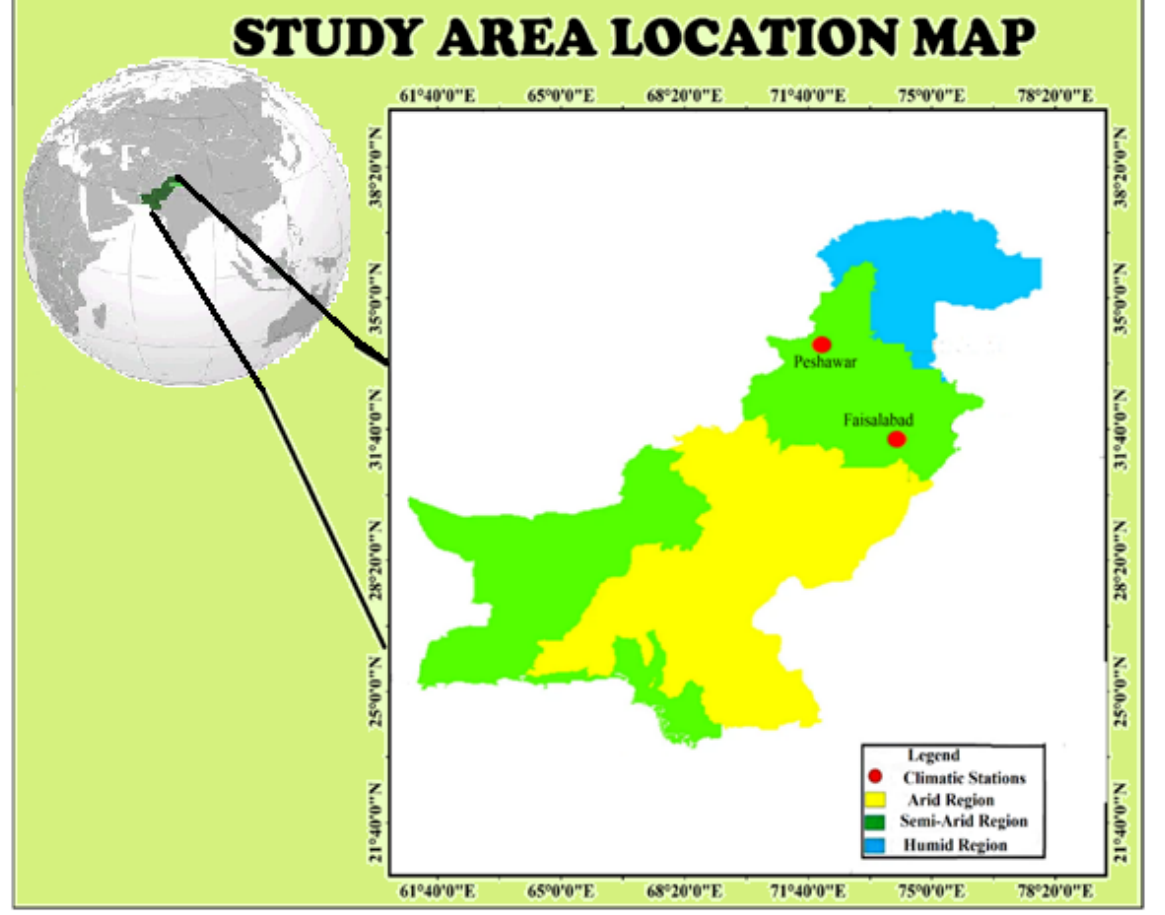
Figure 1. Study area.